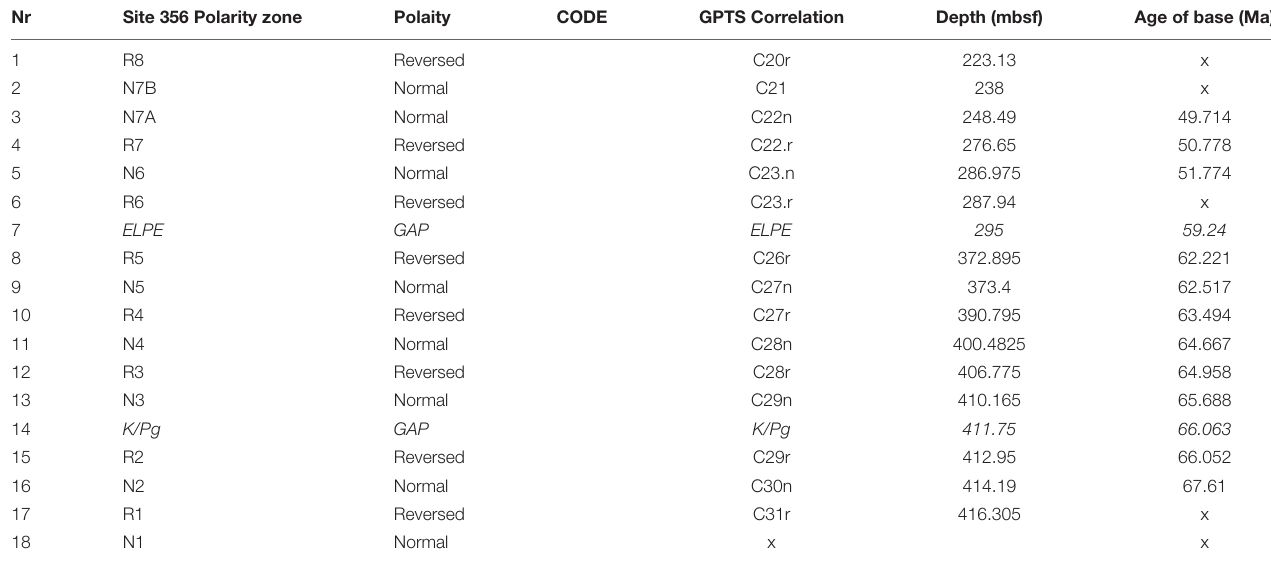
TABLE 2 | Magnetostratigraphic tie-points used in the age model for Site 356. Nr Site 356 Polarity